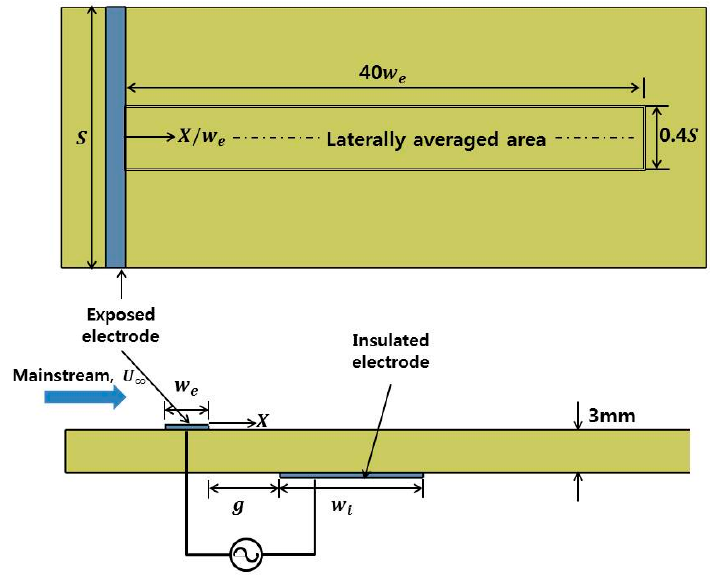
Figure 11. Test setup to investigate the effect of plasma on the PSP emission.